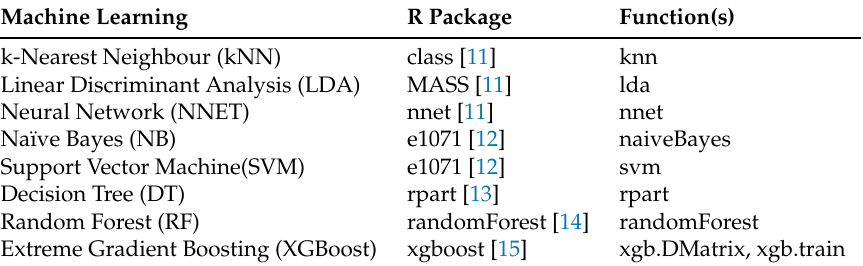
Table 2. List of machine learning methods with R